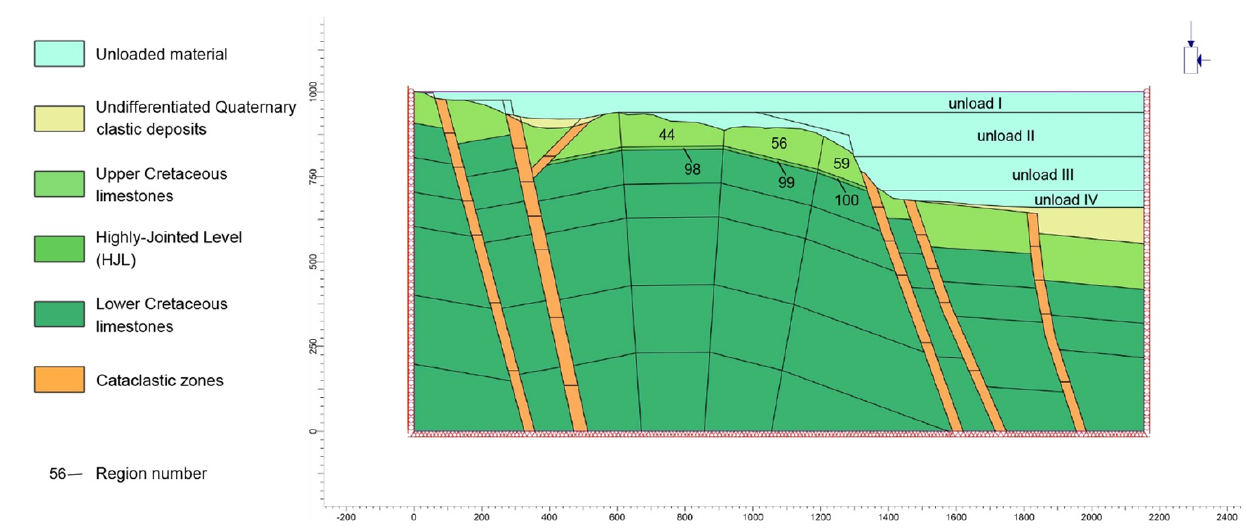
Figure 7. Engineering-geological model used in the numerical analyses, showing the 102 regions identified, the different types of materials, and the boundary conditions considered. The model indicates the different unloading stages and the numbers of the regions for which the geomechanical characteristics are described in Tables 3–5. x -axis is in meters, while y -axis is in meters a.s.l. The unit weight of each single region was estimated according to Discenza et al.